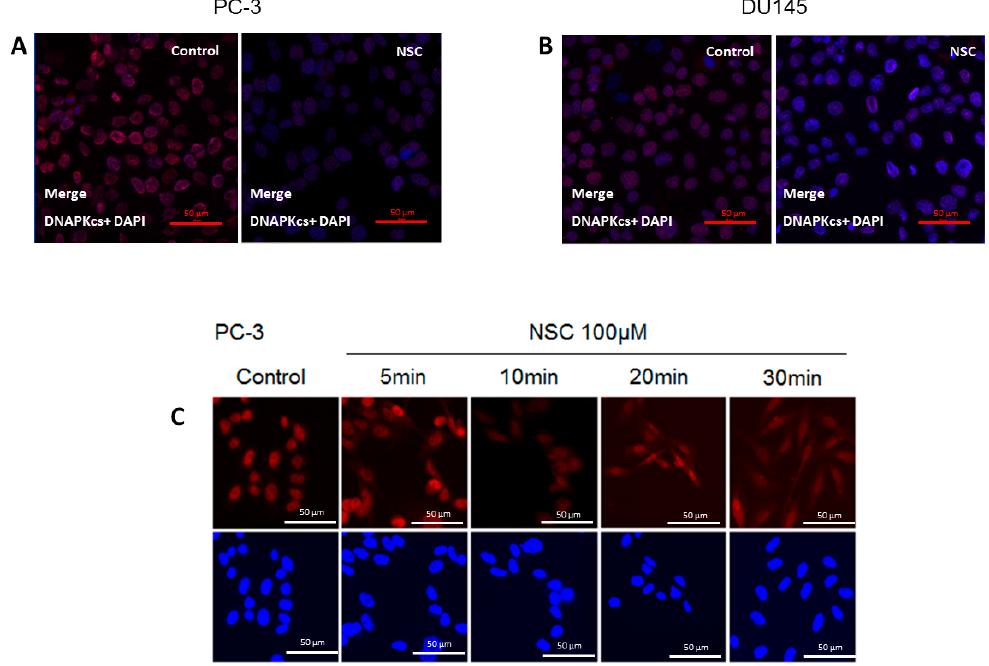
Figure 2. Intracellular localization of DNA-PKcs in prostate cells exposed to NSC. PC-3 ( A ) and DU145 ( B ) cells exposed to 100 µM NSC (NSC) or to vehicle (Control) for 10 min; ( C ) DNA-PKcs intracellular distribution in PC-3 was also analyzed after NSC treatment at 100 µM for 5, 10, 20 and 30 min. The treated and untreated cells were fixed and stained with anti-DNA-PKcs antibody (red color). The nuclei were stained with DAPI (blue color).